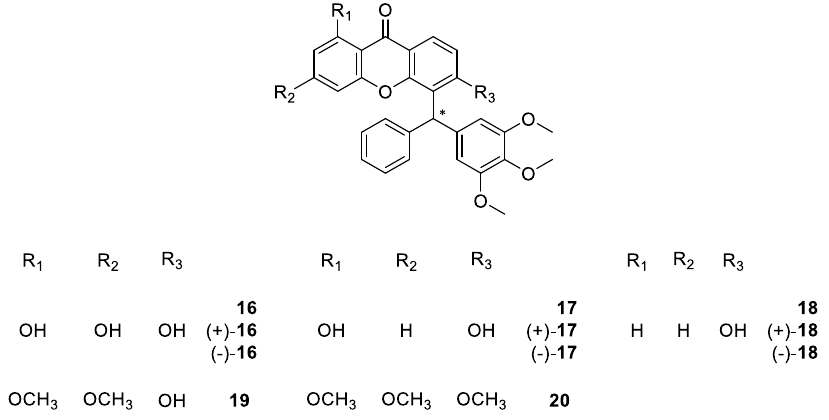
Figure 3. Structures of muchimangin derivatives 16 – 20 .